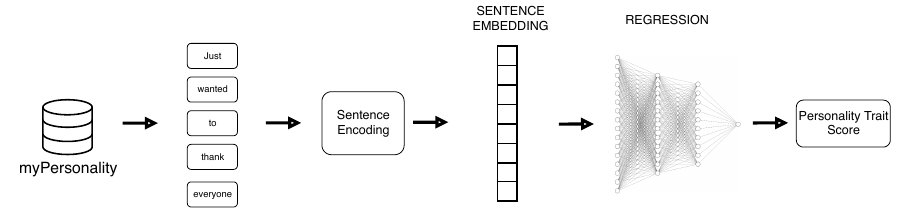
Figure 2. The pipeline representing the whole process from raw text through sentence encoding and then the stacked neural network to predict the personality trait. As shown in the figure, we compute one personality trait out of the five in the Big 5 model. The same pipeline is adopted to compute one by one each of the five personality